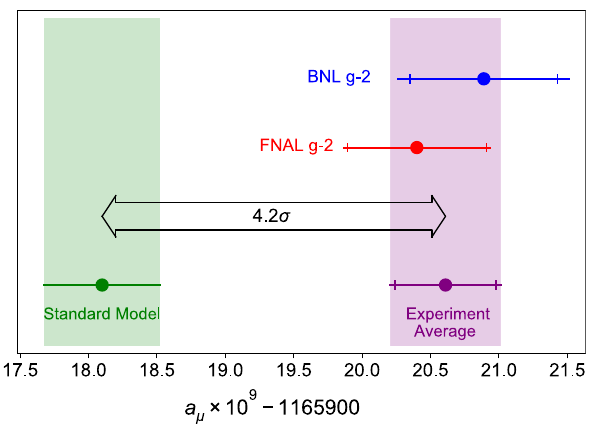
Fig. 1 Current status of the discrepancy between experiment and SM predictionforthemuonanomalousmagneticmoment(figuretakenfrom